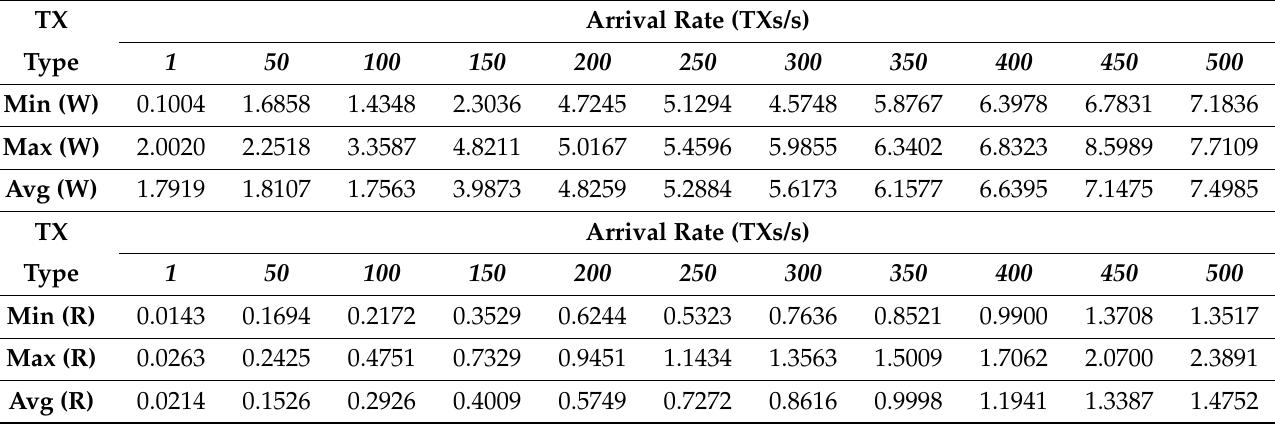
Table 4. Latency measures, in seconds, for read (R) and write (W) TXs in a local Docker environment where network size =